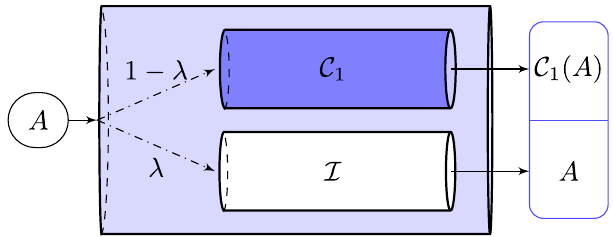
Fig. 4 Incomplete erasure channel C . Channel C ’ s input A , with probability λ goes via I (the identity channel) to an output subspace as A , or else via C 1 (a noisy channel) to an orthogonal subspace as C 1 ð A Þ . When C 1 ¼ T (where T ð A Þ ¼ Tr ð A Þ 0 j i 0 h j ) then C becomes the usual erasure channel with erasure probability 1 − λ , whose quantum capacity is zero for λ ≤ 1/2. However, an application of Theorem 1 shows that as C is changed from T 1 to one of several different zero capacity qubit channels, coherent information of C becomes positive for all λ >